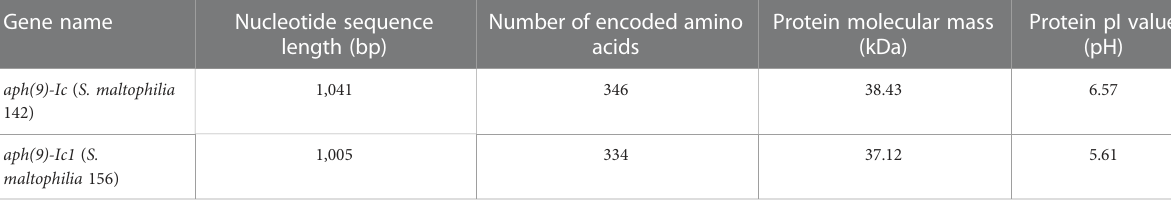
TABLE 4 Basic properties of aph(9)-Ic and aph(9)-Ic1 and their proteins.